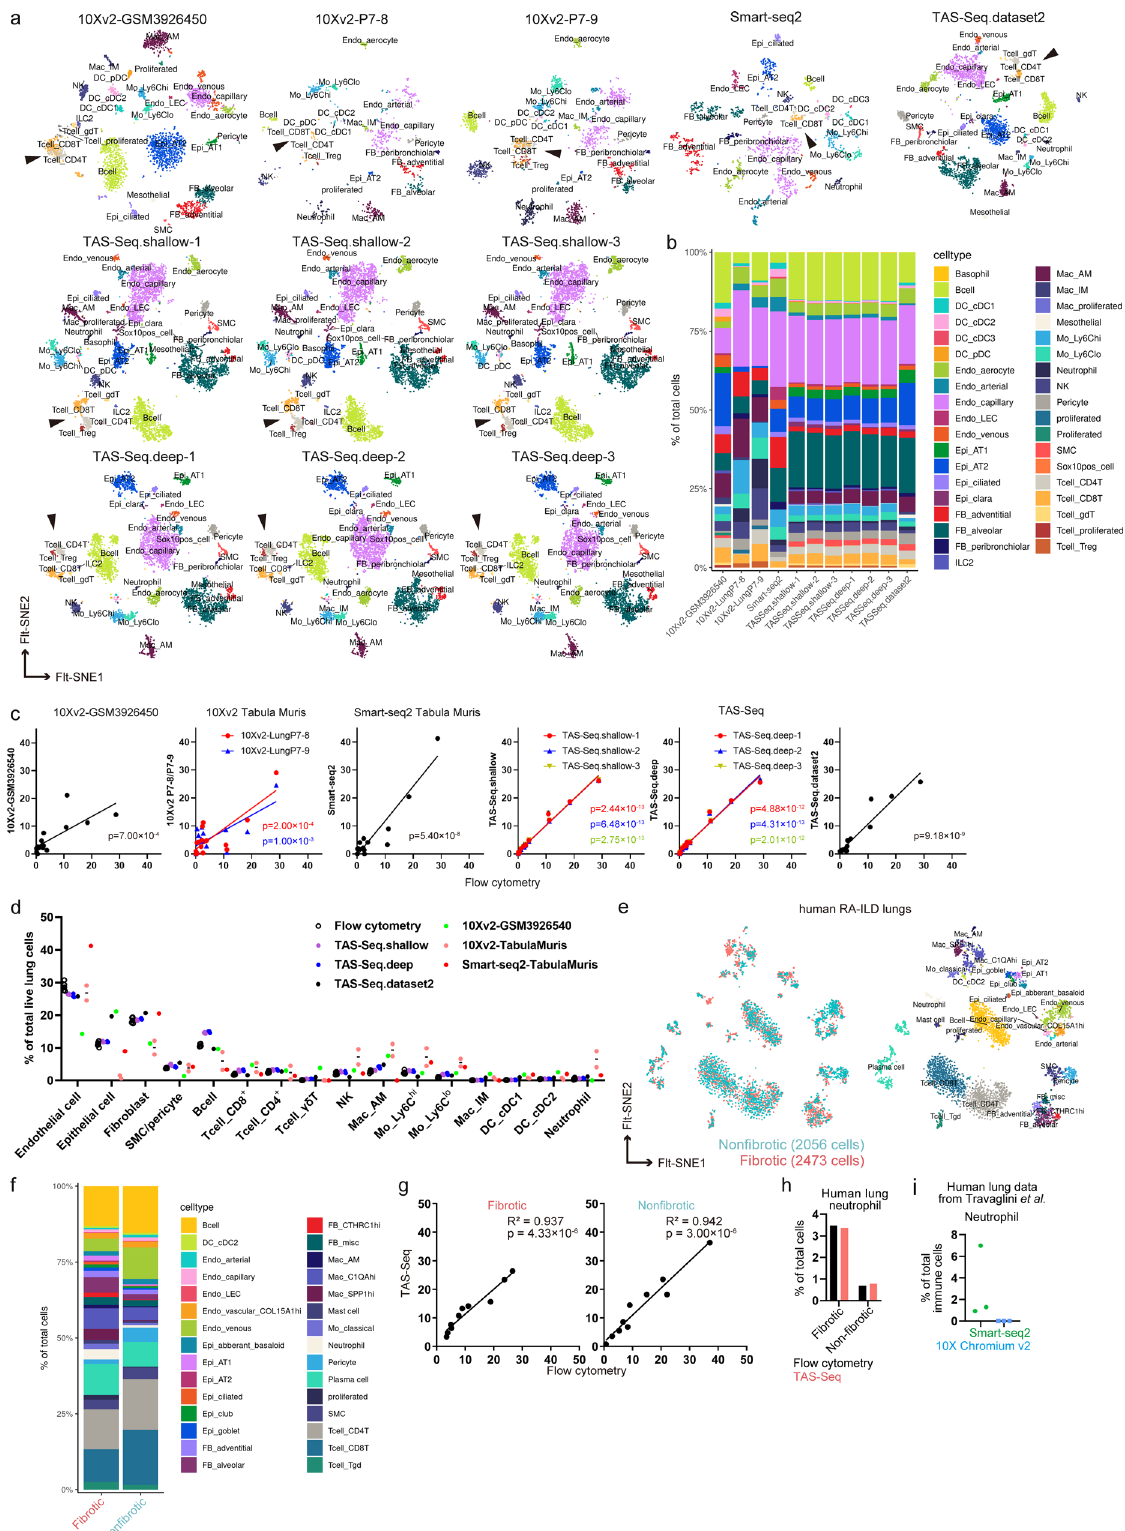
TAS-Seq detects more genes with a lower drop-out rate than Smart-seq2 and 10X v2 in murine lung cell subsets . Because the gene-detection rate was different between different lung cell subsets, we next compared the number of detected genes in TAS- Seq, Smart-seq2, and 10X v2 datasets within commonly detected cell subsets. TAS-Seq detected signi fi cantly more genes than